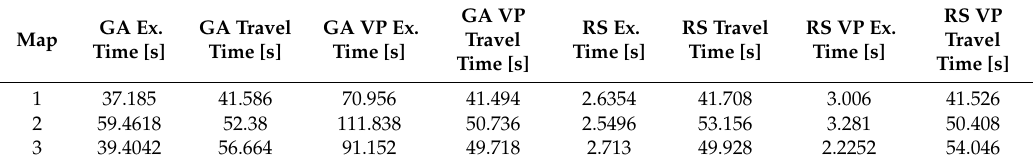
Table 4. Average times of algorithm execution and travel.